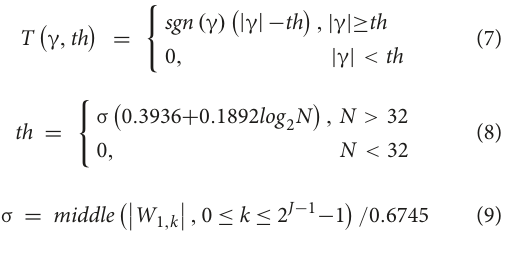
is in the form of a matrix of size 4 (channels) × 32 (data